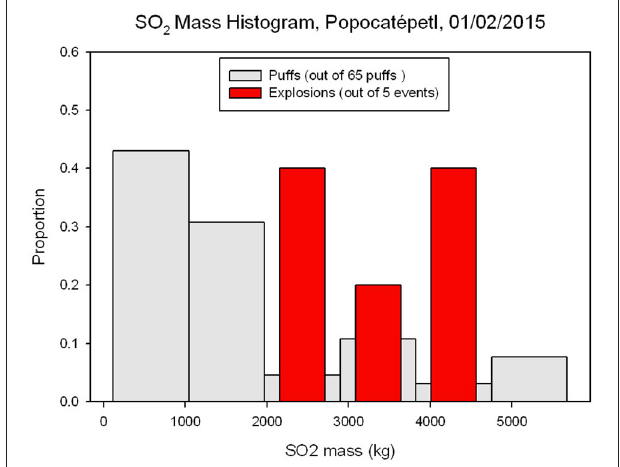
FIGURE 8 | Histogram comparing the frequency distribution of the SO 2 masses emitted by individual puffs of passive degassing and by E1 explosions, on a same